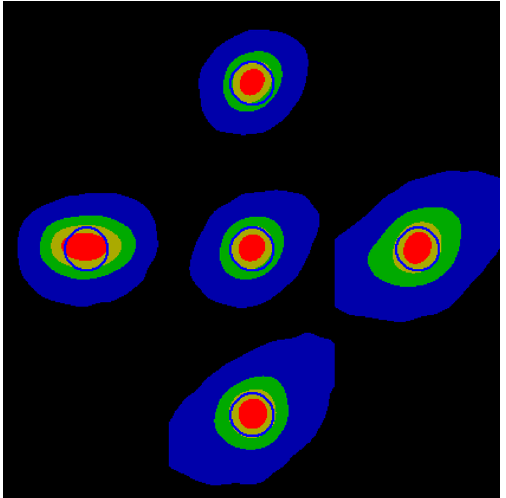
Figure 9. Effect of adjusting focus value and filament current (see Fig. 7 for colour scale. Centre: Optimal. Left: Focus -10. Right: Focus + 10. Top: Filament current + 5. Bottom: Filament current −